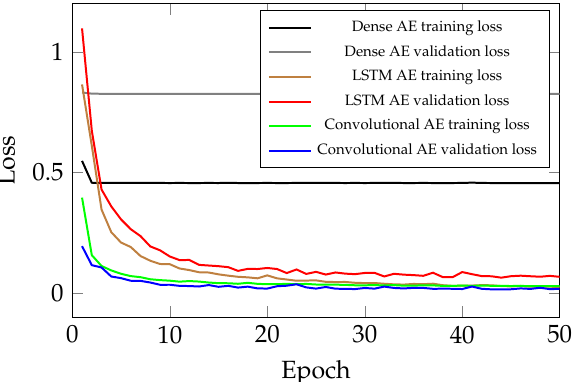
Figure 11. Learning curve of the different AEs for the barrel movement. AE with convolutional layers has the highest generalization power given the validation